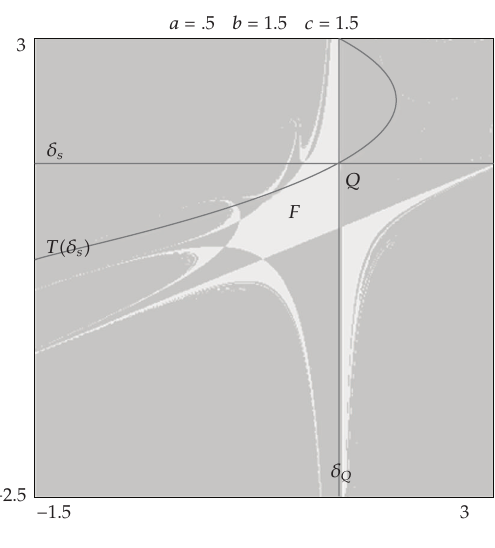
Figure 2: b (cid:2) 1 . 500 basin-bifurcation value.